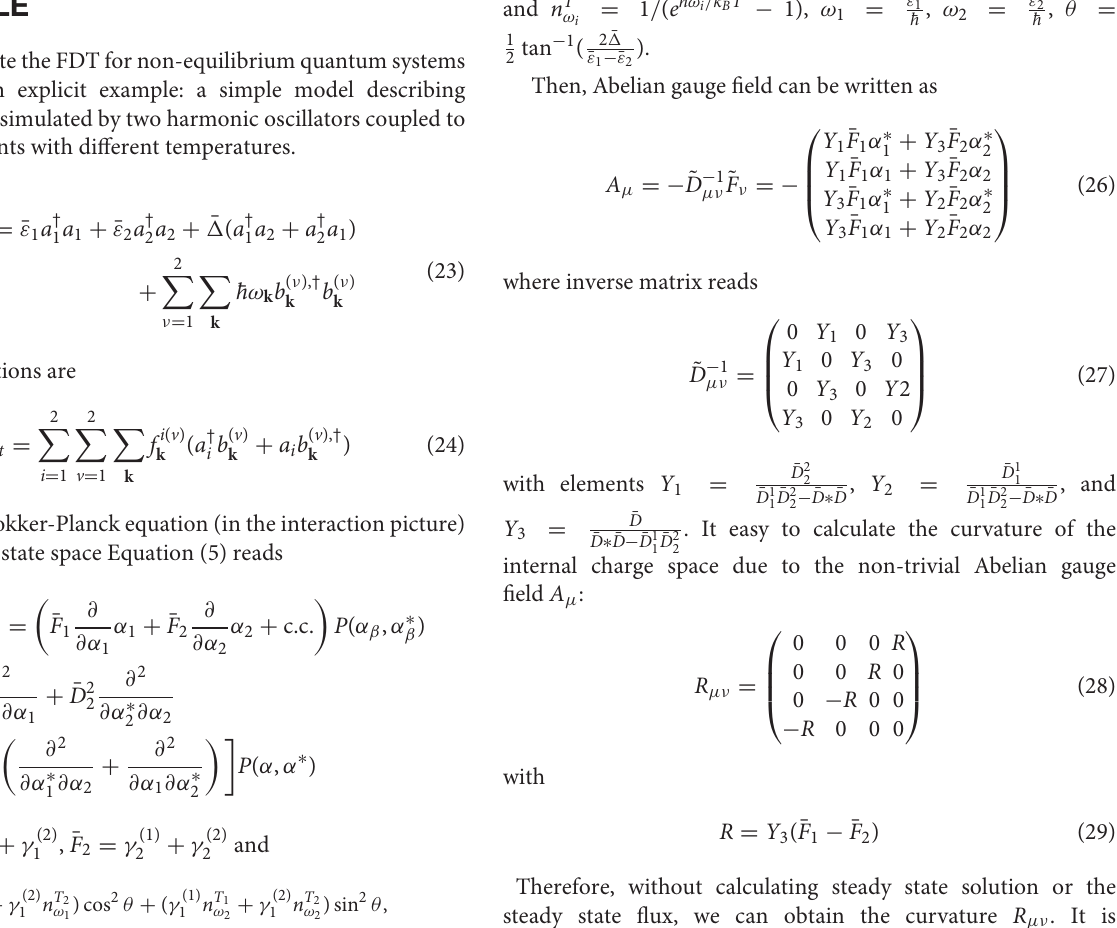
ε 1 ε 2 0.4 ev . Other parameters are F 1 = − =